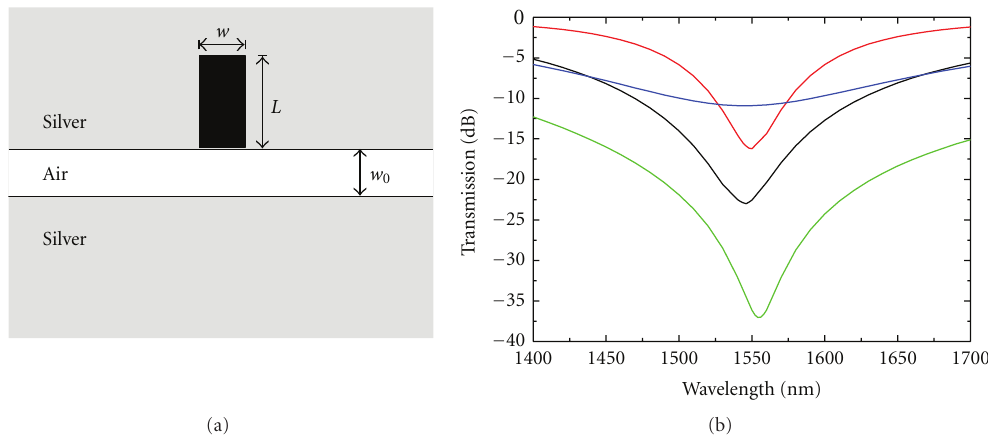
Figure 5: (a) Schematic of a switch consisting of a silver-air-silver MDM plasmonic waveguide side-coupled to a cavity filled with an absorbing material with refractive index n = 2 . 02 + iκ . The imaginary part κ of the refractive index can be modified with an external control beam. (b) Transmission spectra of the switch calculated using FDFD. Results are shown for w = 50 nm, L = 120 nm, κ = 0 (black curve), w = 50 nm, L = 405nm, κ = 0 (red curve), w = 200nm, L = 175 nm, κ = 0 (green curve), and w = 50 nm, L = 120 nm, κ = 0 . 1 (blue curve). In all cases w 0 = 50 nm and λ 0 = 1 . 55 μ